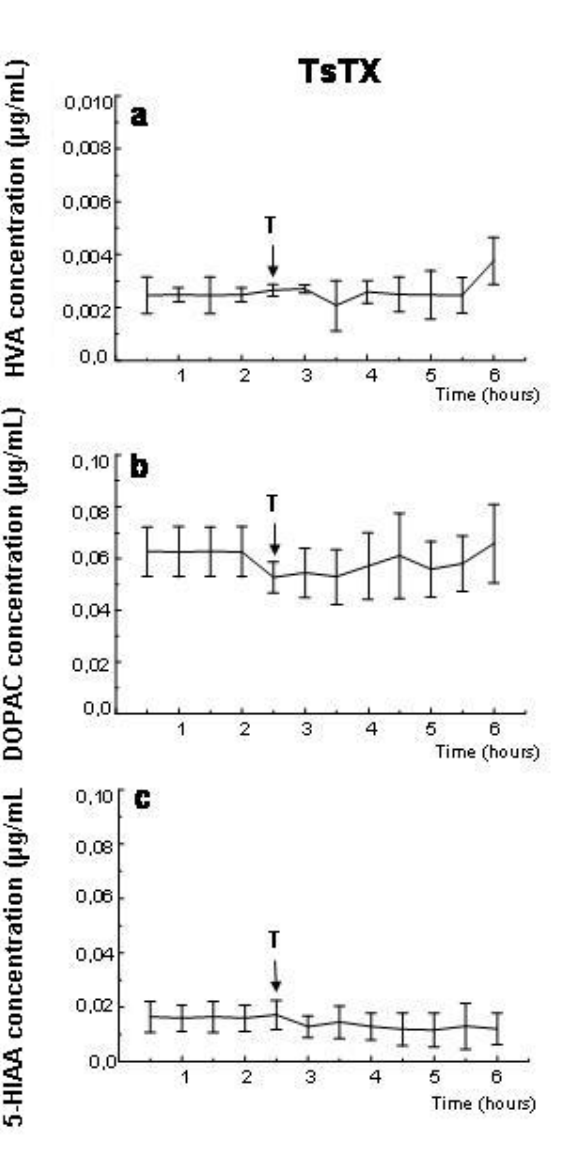
Figure 1. Extracellular levels of hippocampal HVA ( a ), DOPAC ( b ) and 5-HIAA ( c ). Levels determined by microdialysis in conscious rats before and after ipsilateral intrahippocampal injection of 2 µg TsTX. Arrows indicate time of toxin (T) injection. Error bars show standard deviation p < 0.05 compared to pre-injection level, one-way repeated measures ANOVA and Tukey’s test. All groups n = 5.